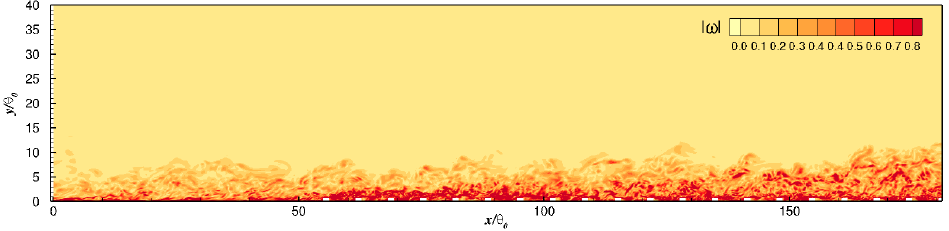
Figure 1. Visualization of enstrophy | ω | near the STR step change using an instantaneous side view of the DNS. The white-colored rectangles at the bottom wall represent individual roughness ele- ments.